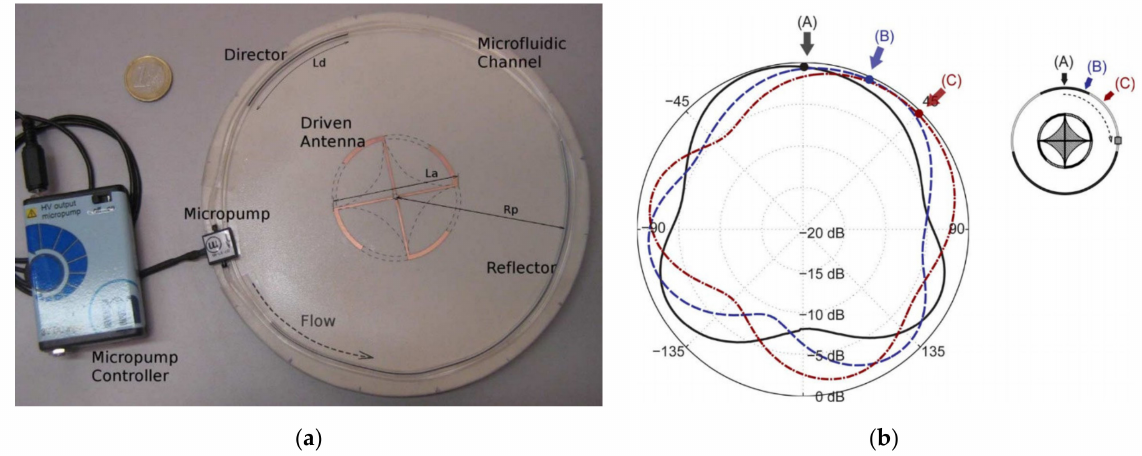
Figure 11. ( a ) Photograph of the microfluidic reconfigurable antenna. ( b ) Measured radiation patterns for configurations corresponding to rotations of 0 ◦ , 22.5 ◦ and 45 ◦ . Reprinted with permission from Ref. [50]. Copyright IEEE